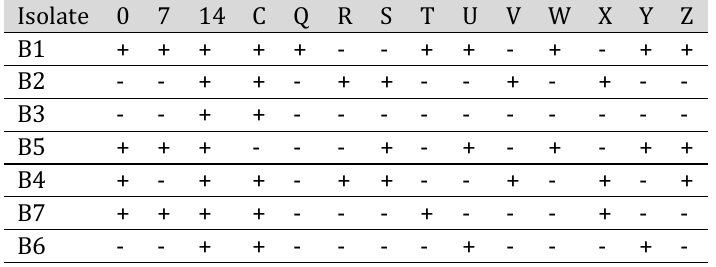
Table 7. Occurrence of bacterial isolates in the analyzed palm fruits and palm oil